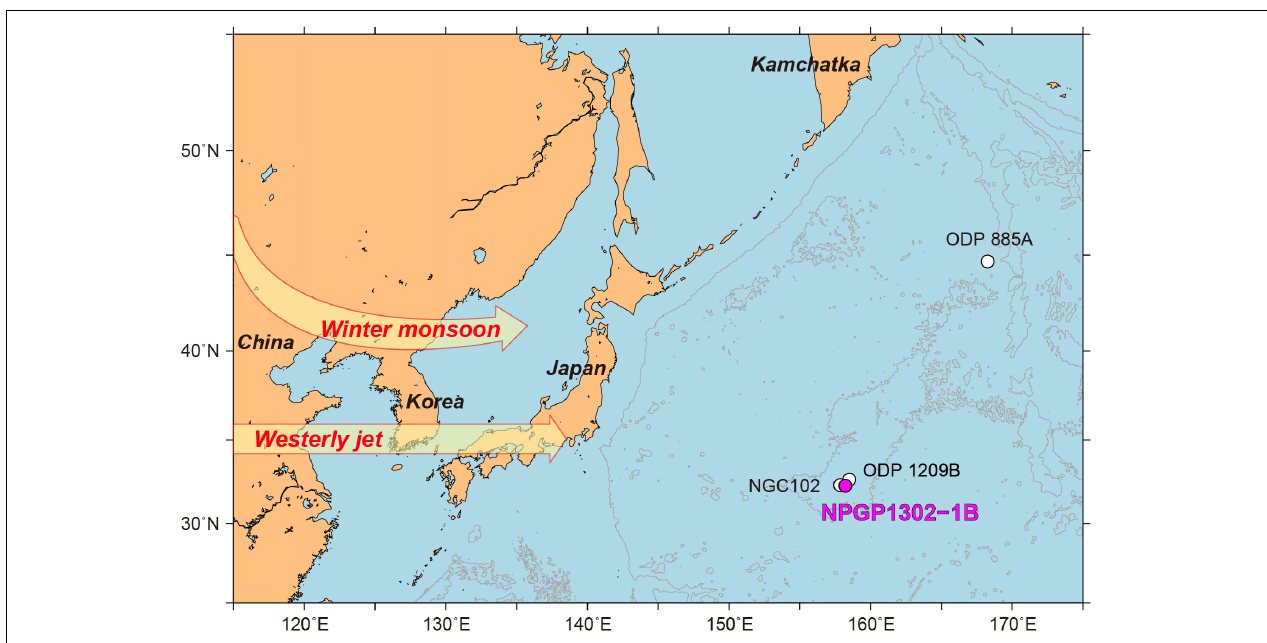
FIGURE 1 | A map showing the location of the studied core NPGP1302-1B. Cores referred in this study are also shown. In the North Pacific, eolian dust and volcanic materials are transported by the Westerly jet and the East Asian winter monsoon (yellow shaded